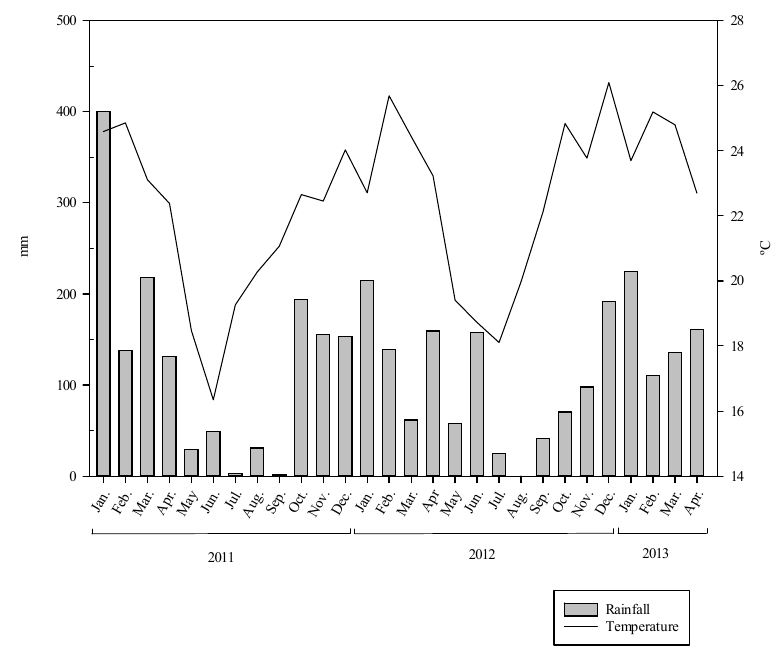
Figure 1. Temperature and rainfall during the months of the experiment, on average.